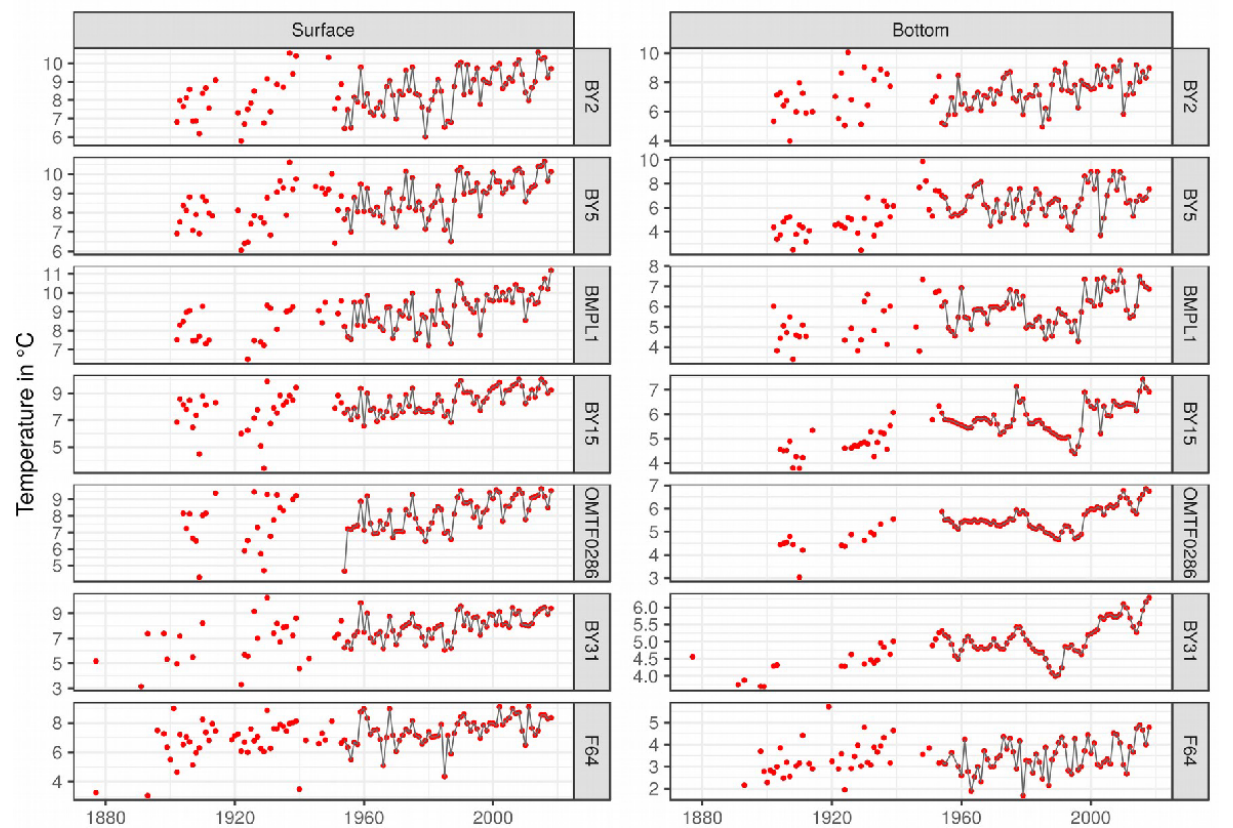
Figure 18. Annual mean values of deseasonalised daily sea surface (left column) and bottom (right column) temperature (red dots) at seven monitoring stations during 1877–2018. For the location of the stations, see Fig. 2. The grey lines show the period when every station has data for every year (1954–2018). Data source: for Figs. 18, 19, 21, and 22, ICES data (https://www.ices.dk/data/data-portals/Pages/ocean.aspx, last access: 21 February 2022) for temperature and salinity (bottle data; i.e. from specific depths) were used. Postprocessing of the data was done, following Radtke et al. (2020), in order to overcome possible seasonal biases due to missing values in the observations. Therefore, gaps were statistically filled using GAMMs (general additive mixed models), taking the seasonality into